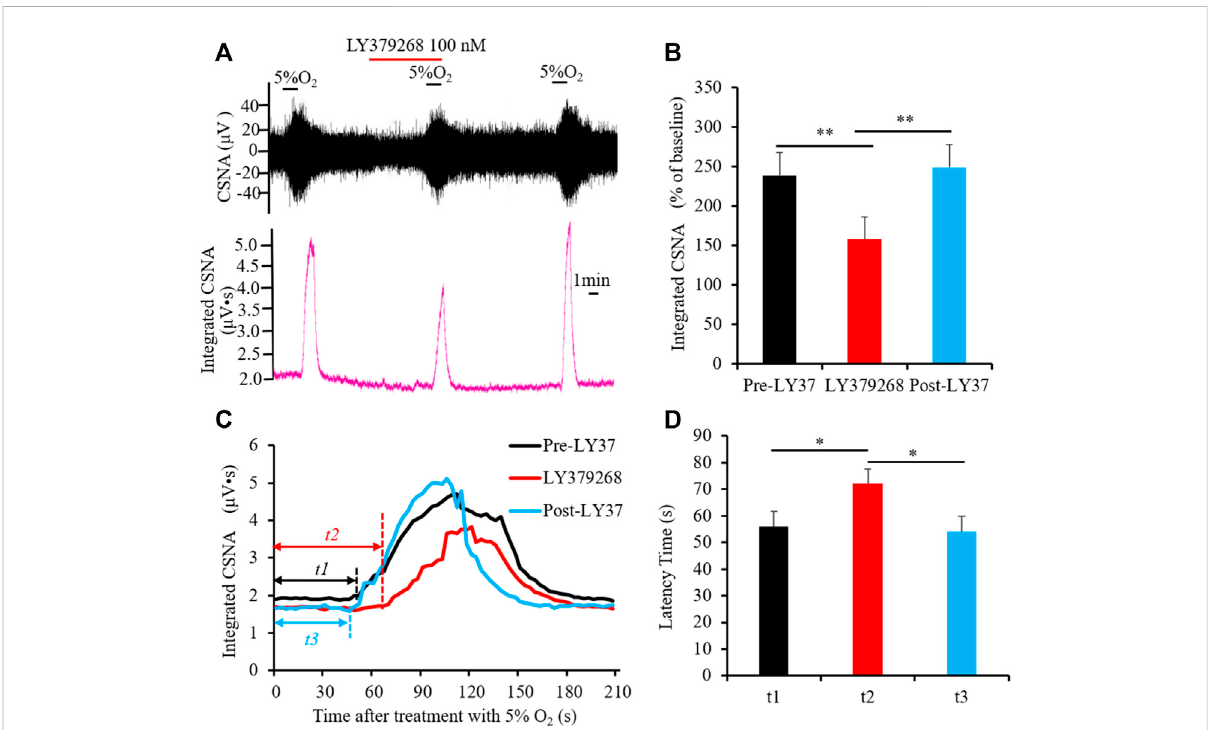
FIGURE 4 LY379268 attenuates CB response to hypoxia. (A,B) LY379268 (100 nM) inhibited hypoxia-evoked CSN discharge. (A) Shows the representative recordingsofCSNdischargeandintegratedCNSAbefore,after,andposttreatmentofLY379268(Pre-LY37,LY37andPost-LY37); (B) revealsthedata analysis of hypoxia-evoked integrated CSNA, represented as the percentage of baseline. (C,D) LY379268 extended the duration of hypoxia-evoked CSN fi ring. t represents the latency time that is referred to as the time from superfusion hypoxia solution to the onset of CSN sharply fi ring. t1 : Latency time of CB response to hypoxia before treatment with LY379268 (Pre-LY37); t2 : Latency time of CB response to hypoxia while treated with 100 nM LY379268 (LY37); t3 :Latency time of CB response to hypoxia after wash out LY379268 (Post-LY37). (C) Shows therepresentative recordings of integrated CNSA in the condition of Pre-LY37, LY37, and Post-LY37; (D) reveals the data analysis of the latency times of CB response to hypoxia in theconditionofPre-LY37,LY37,andPost-LY37.LY37:representsLY379268andgroupIImGluRsagonist;CSNA:carotidsinusnerveactivity.Thedata were presented as mean ± SEM. n = 4, ** p < 0.01 and * p < 0.05 indicate signi fi cant difference (One-Way ANOVA with repeated